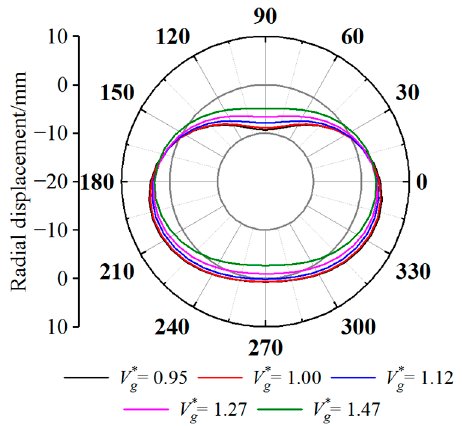
V ∗ . Figure 27. Lining ovality under different synchronous grouting ratios V ∗ g V ∗ . g g